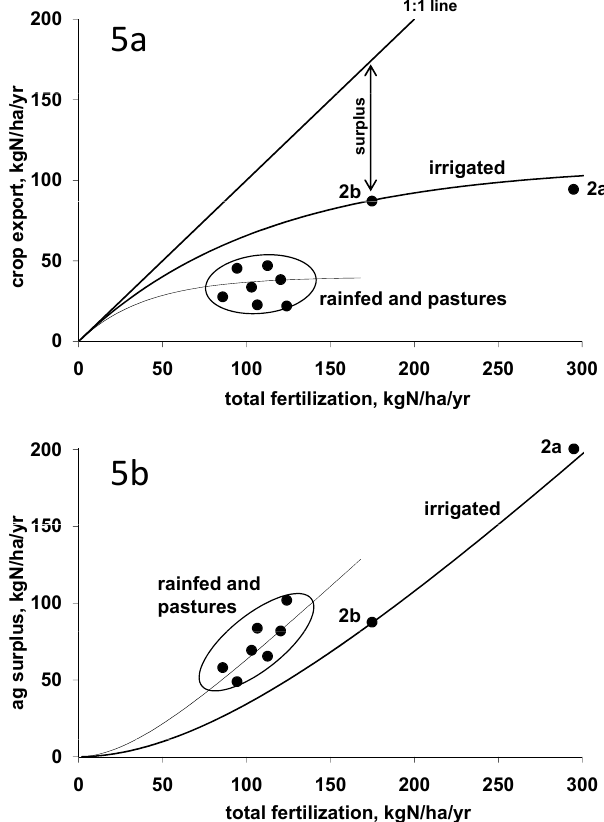
(a) Relationship between total fertilization and crop export. The single parameter relationship y = Y max (1- e − x / Y max ) (where y is crop export and x total fertilization) has been fitted to the observations. (b) Corresponding relationship between total fertilization and agricultural surplus (surplus is defined as total fertilization minus crop export). Note: territorial units 2a and 2b are those with a higher proportion of irrigated crops (see Table